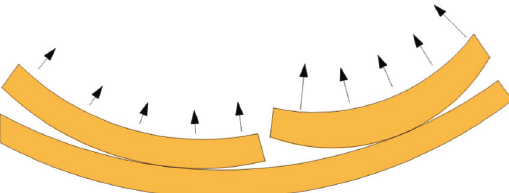
Figure 10: Diagram of curling phenomenon and crack in tearing